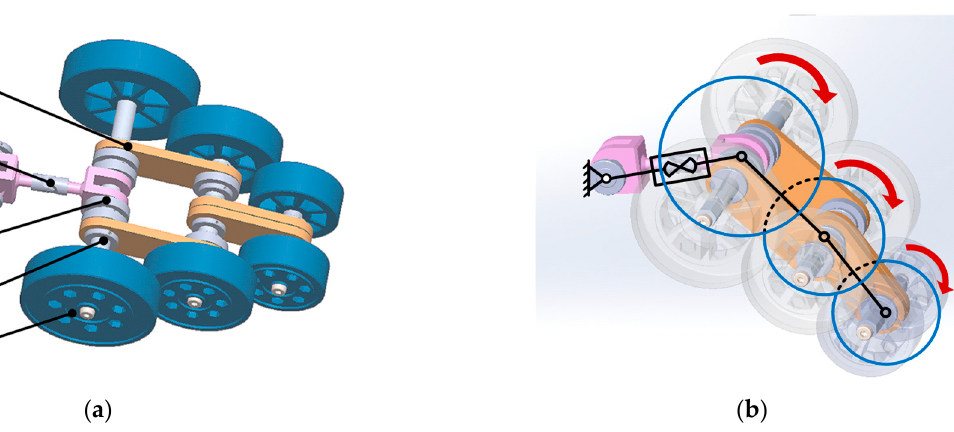
Figure 4. Adaptive tail. ( a ) Structure of the adaptive tail; ( b ) Sketch of the motion of the adaptive tail